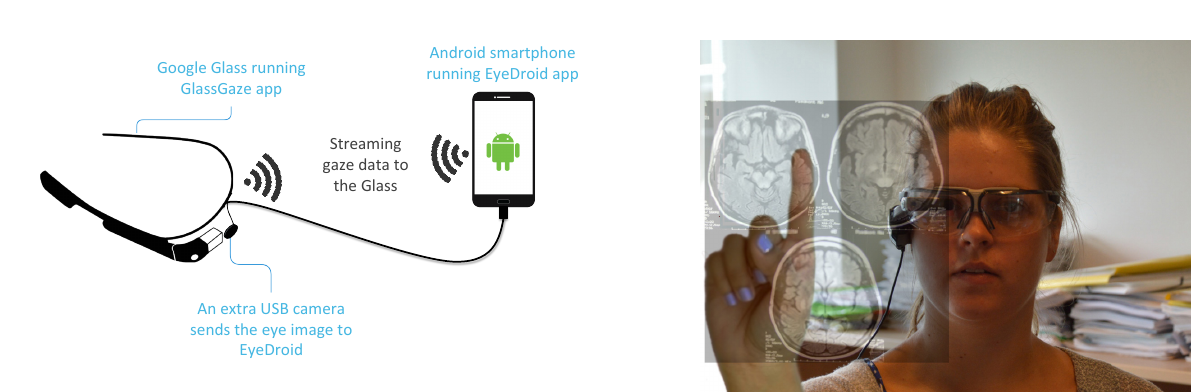
Figure 9. A schematic view of the GlassGaze/EyeDroid system architecture.